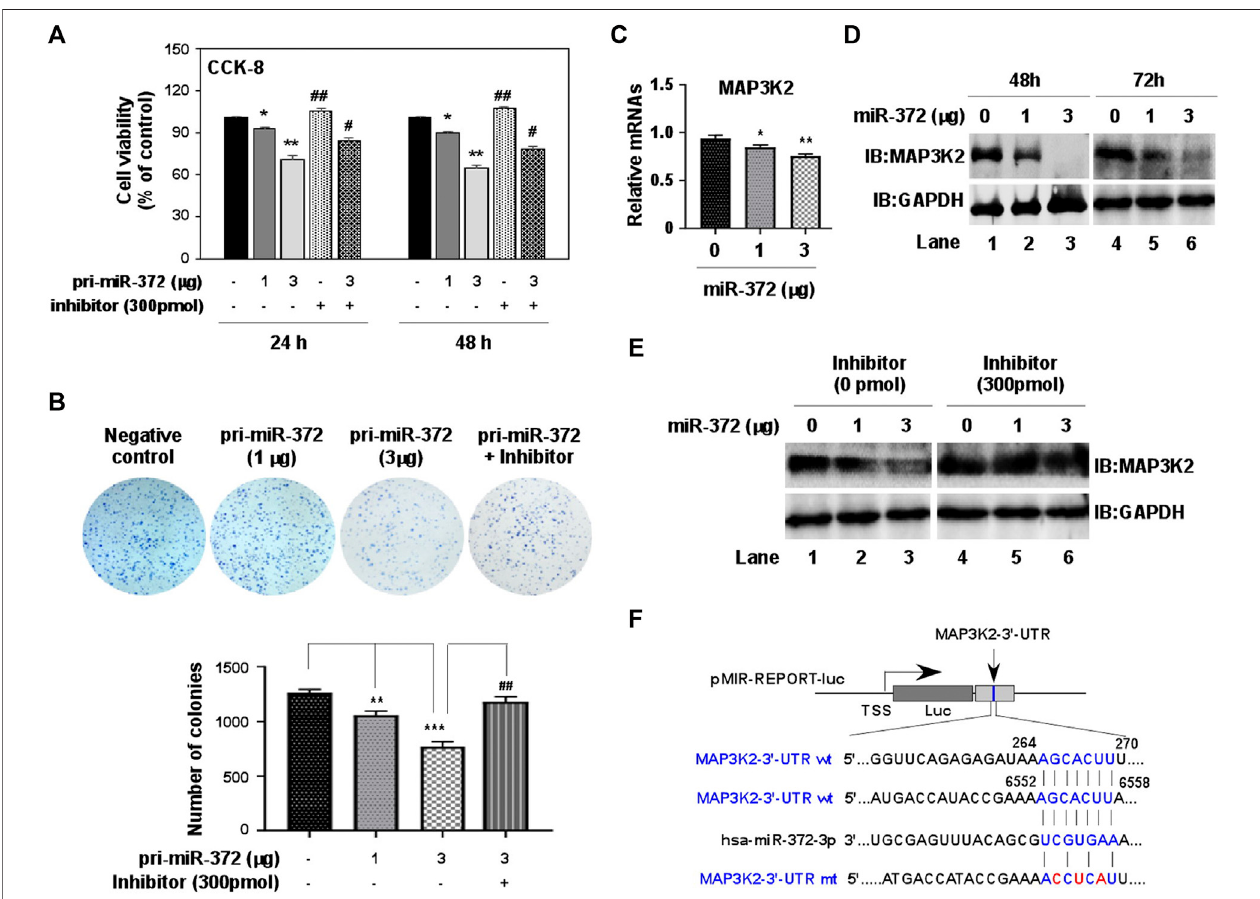
FIGURE5| miR-372-3psuppressedcellproliferationinSW480coloncancercells,andalsonegativelyregulatedMAP3K2expression. (A) SW480cellproliferation was inhibited by miR-372-3p mimics. SW480 cells were transiently transfected with miR-372-3p mimics in the presence or absence of miR-372-3p inhibitors. The cell viability was then detected using a CCK-8 assay kit at 24 and 48 h. Data are presented using mean ± standard deviation values. * p < 0.05, ** p < 0.001, vs. the vector group, # p < 0.05, ## p < 0.01, vs. the miR-372-3p 3 µg group (Mann Whitney test). (B) Colony-formation assay. The colony-formation ability of SW480 cells was analyzed with a colony formation assay (upper), and the quanti fi ed numbers of colonies for each group are displayed as a bar graph (lower). Data are presented using mean ± standard deviation values. ** p < 0.01, *** p < 0.001, vs. The vector group, ## p < 0.01, ### p < 0.001, vs. the miR-372-3p 3 µg group (Mann Whitney test). (C,D) EffectsofmiR-372-3pontheMAP3K2expressioninSW480cells.CellsweretransfectedwithmiR-372-3p mimics(0,1,3 µg).MAP3K2mRNAwasdetectedusingRT- qPCR (at 48 h) (C) , and the protein levels were analyzed with western bloting (at 48 and 72 h) approach (D) . GAPDH was used as an internal control. (E) The MAP3K2 protein level reduced by miR-372-3p was restored by co-transfection with miR-372-3p inhibitors in SW480 cells. (F) Binding sites of miR-372-3p on the MAP3K2 3 ′ - UTR. The 3 ′ -UTR fragments of human MAP3K2 (+21 to +472 bp, +6394 to +6656 bp) were cloned downstream of the luciferase between the MulI and HindIII